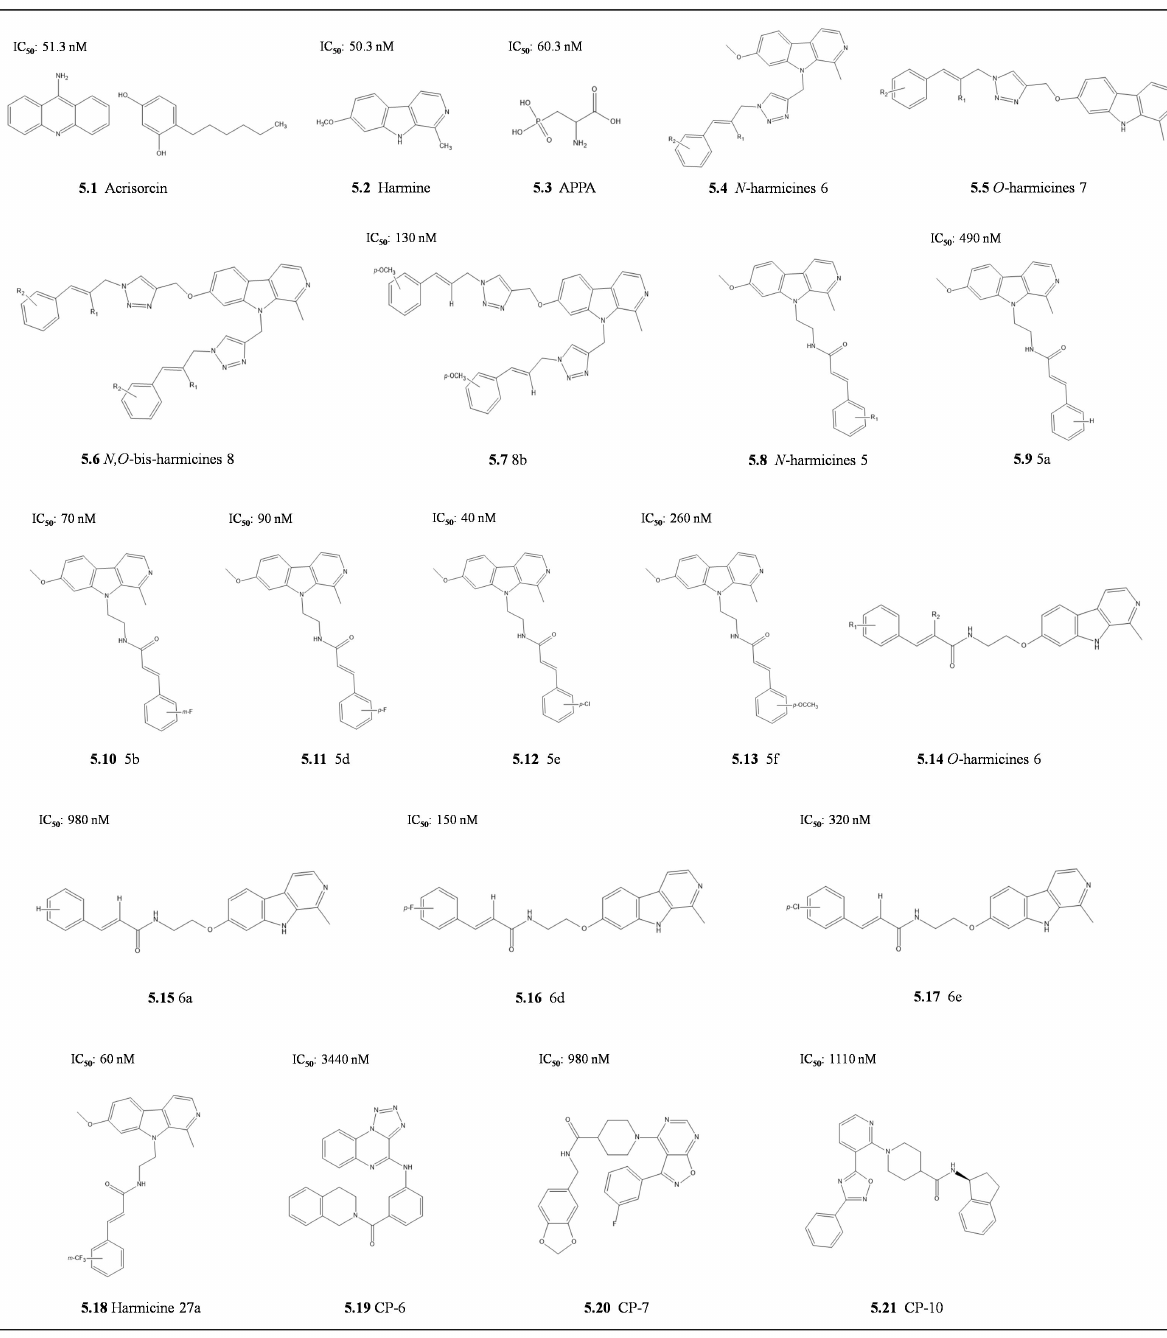
Figure 5. The chemical structure of Harmine and the derivatives. The inhibitors, 5.1 Acrisorcin. 5.2 Harmine. 5.3 2-amino- 3-phospho propionic acid (APPA) were tested in in parsite growth inhibition studies. The 5.4 N -harmicines 6 and 5.5 O -harmicines 7. 5.6 N,O -bis-harmicines 8 and their derivative 5.7 8b. 5.8 N -harmicines 5 and its derivatives 5.9 5a, 5.10 5b, 5.11 5d, 5.12 5e and 5.13 5f. 5.14 O -harmicines 6 and its derivatives 5.15 6a, 5.16 6d and 5.17 6e. 5.18 Harmicine 27a. Other synthetic compounds 5.19 CP-6. 5.20 CP-7. 5.21 CP-10 were also developed. The respective IC 50 values for parasite growth inhibition are